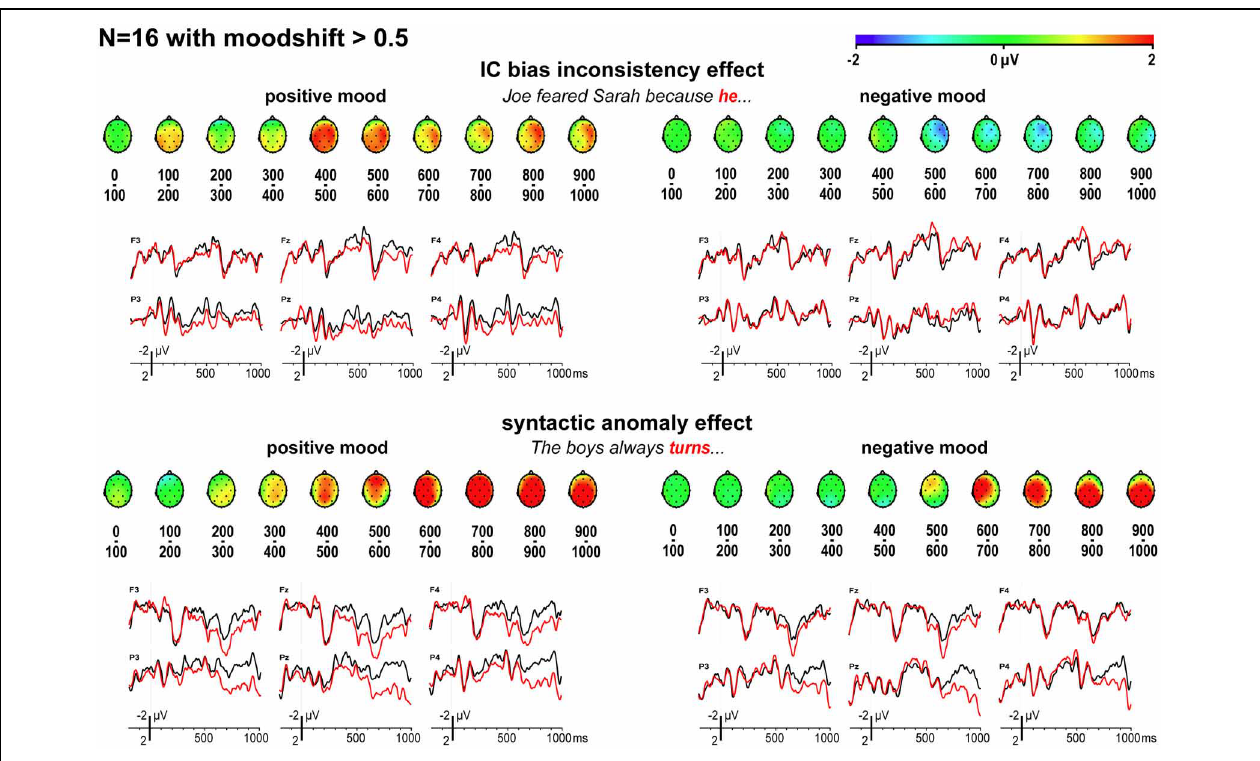
FIGURE 4 | ERP effects for implicit causality and syntax, for mood-responsive participants only. Scalp distributions of differential ERP effects to bias-inconsistent (vs. -consistent) pronouns and syntactically